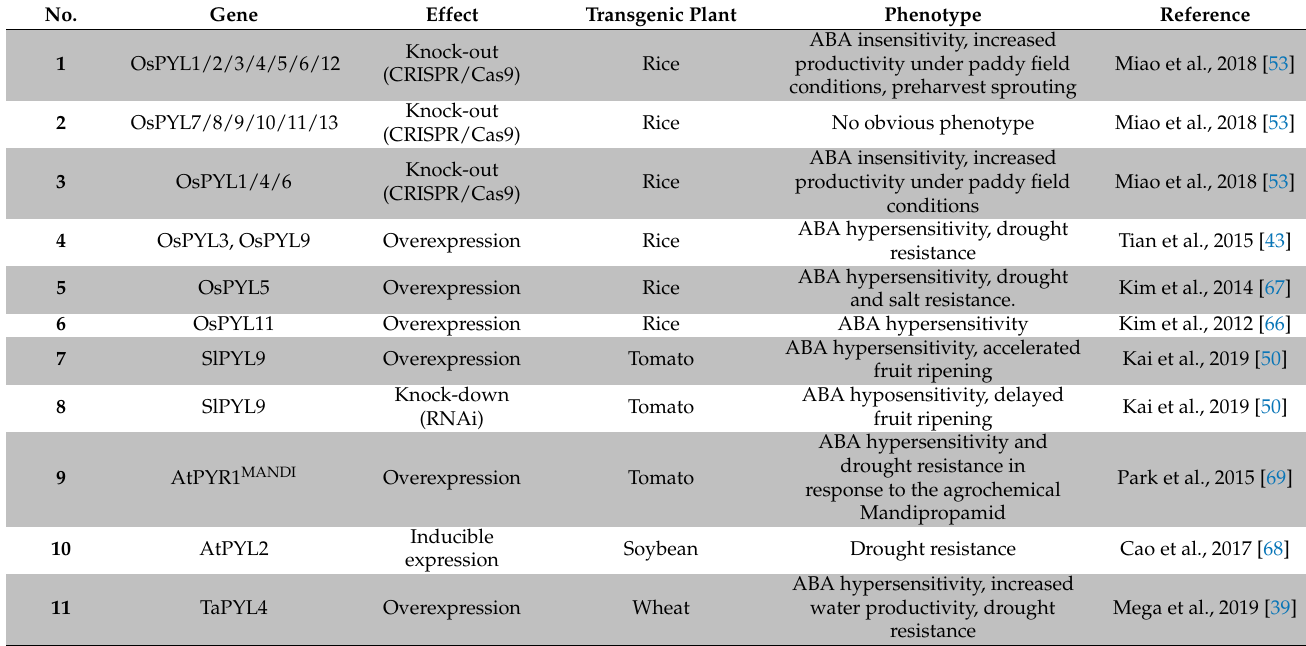
Table 1. Reported transgenic crops with altered PYL expression. The gene code, transgenic effect, transgenic plant, phenotype and reference are